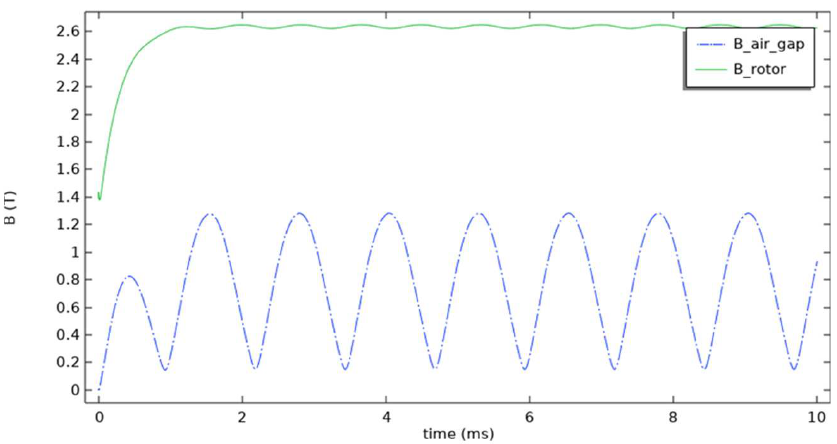
Figure 4. The flux density of rotor and air gap.